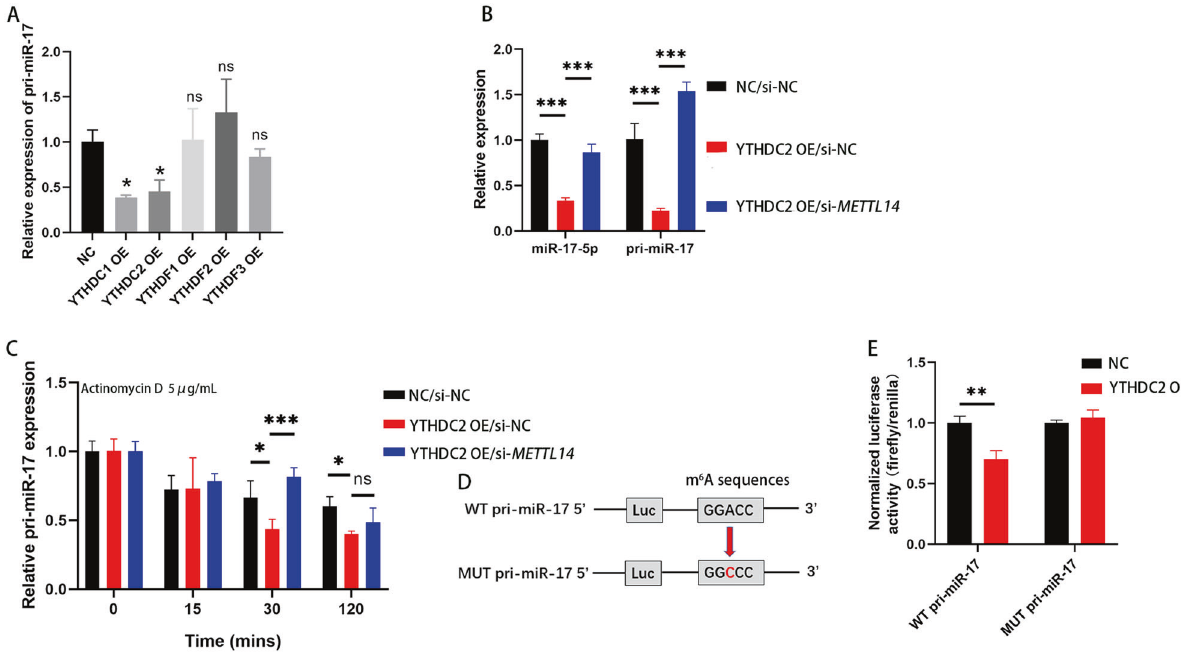
Fig. 5 METTL14 knockdown enhances pri-miR-17 mRNA stability via an m 6 A-YTHDC2-dependent pathway. A Relative expression of pri- miR-17 after HCT116 cells transfected YTHDC1-2, YTHDF1-3 plasmids. P (NC vs. YTHDC1 OE) = 0.0198; P (NC vs. YTHDC2 OE) = 0.0385. B Relative expression of pri-miR-17 and miR-17-5p after HCT116 cells transfected YTHDC2 plasmids and cotransfected si- METTL14 and YTHDC2 plasmids. C PCR analysis of pri-miR-17 levels in different HCT116 cells groups after actinomycin D treatment. D Luciferase vector encoding the wild-type or m 6 A consensus sequence mutated pri-miR-17 were constructed. E YTHDC2 induced the posttranscriptional repression of pri-miR- 17 in HCT116 cells. P (WT pri-miR-17: NC vs. YTHDC2 OE) = 0.0046. Results shown were representative of at least 3 independent experiments. Statistical signi fi cance in ( E ) was assessed by student ’ s t-test. Statistical signi fi cance in ( A – C ) was determined by one-way ANOVA with Dunnett ’ s multiple comparisons test. *, P < 0.05; **, P < 0.01; ***, P < 0.001. Error bars, SD. The grey value of protein bands has been quanti fi ed by Image